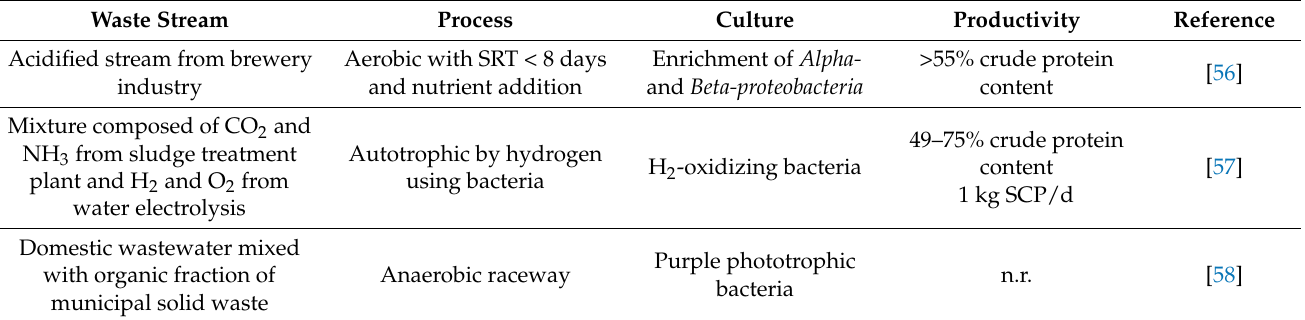
Table 5. Single cell protein production from different streams at